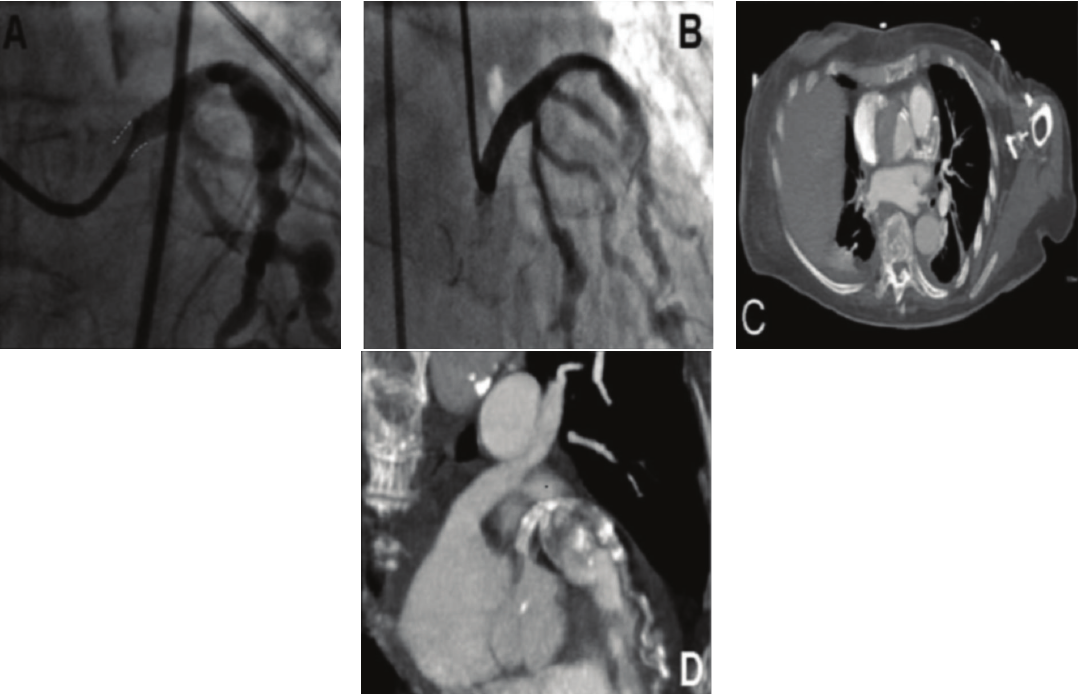
Figure 2: Angiographic projections in (A) and (B); (A) (35 ◦ LAO and 24 ◦ CRA): significant length reduction (dashed lines) of the LMCA; (B) (28 ◦ RAO and 6 ◦ CAU): PCI with implantation of 4.5 × 13mm BMS on the proximal tract of the LMCA overlapping with the previously implanted stent. CT scan in (C) (axial scanning) and (D) (3D volume rendering reconstruction) whereby aortic dissection involving the LMCA ostium and thrombosis of the coronary aneurism are seen. LAO: left anterior oblique; RAO: right anterior oblique; CRA: cranial; CAU: